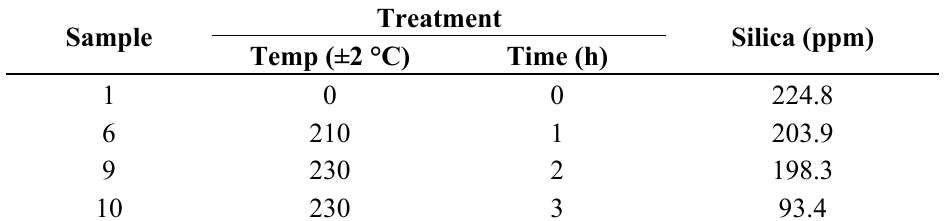
Table 3. Content of silica in untreated OPMF and after superheated steam